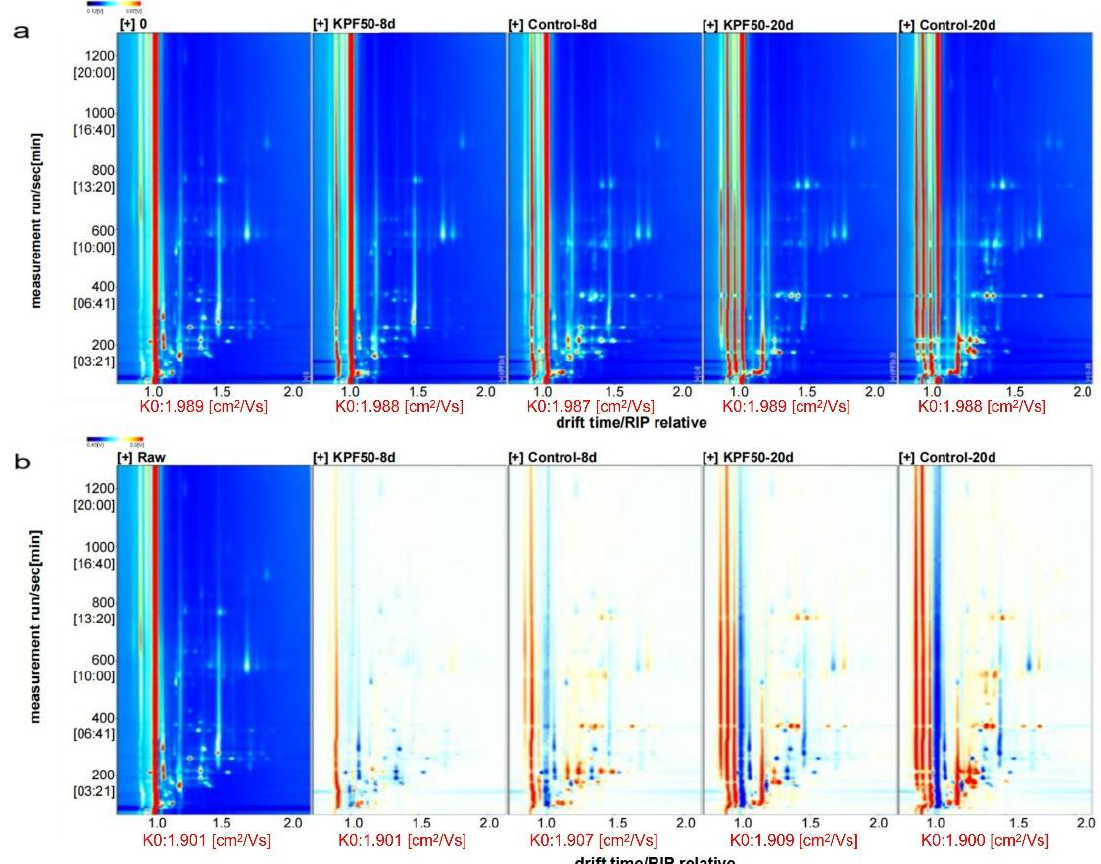
Figure 3. 2D GC-IMS spectra of volatile organic compounds in sea bass samples: ( a ) direct comparison; ( b ) difference comparison.